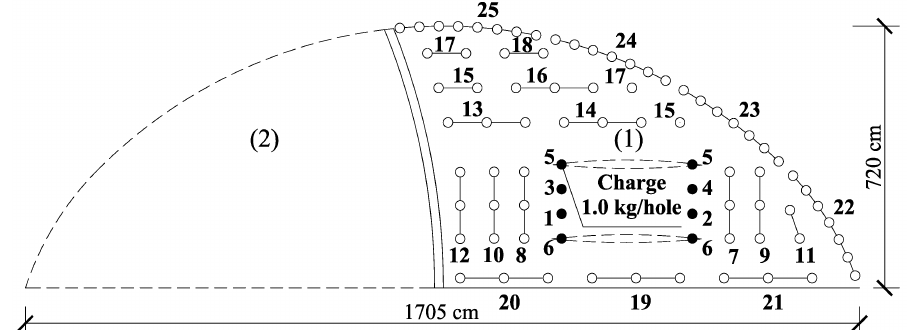
Figure 13. Blasting excavation design of CD method.